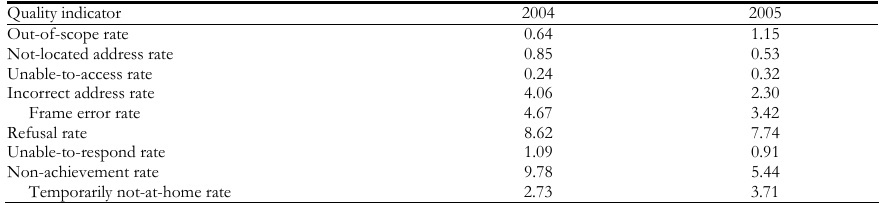
EU-SILC cross-sectional sample: eligibility, non-contact and non-participation rates – waves 2004 and 2005 Quality